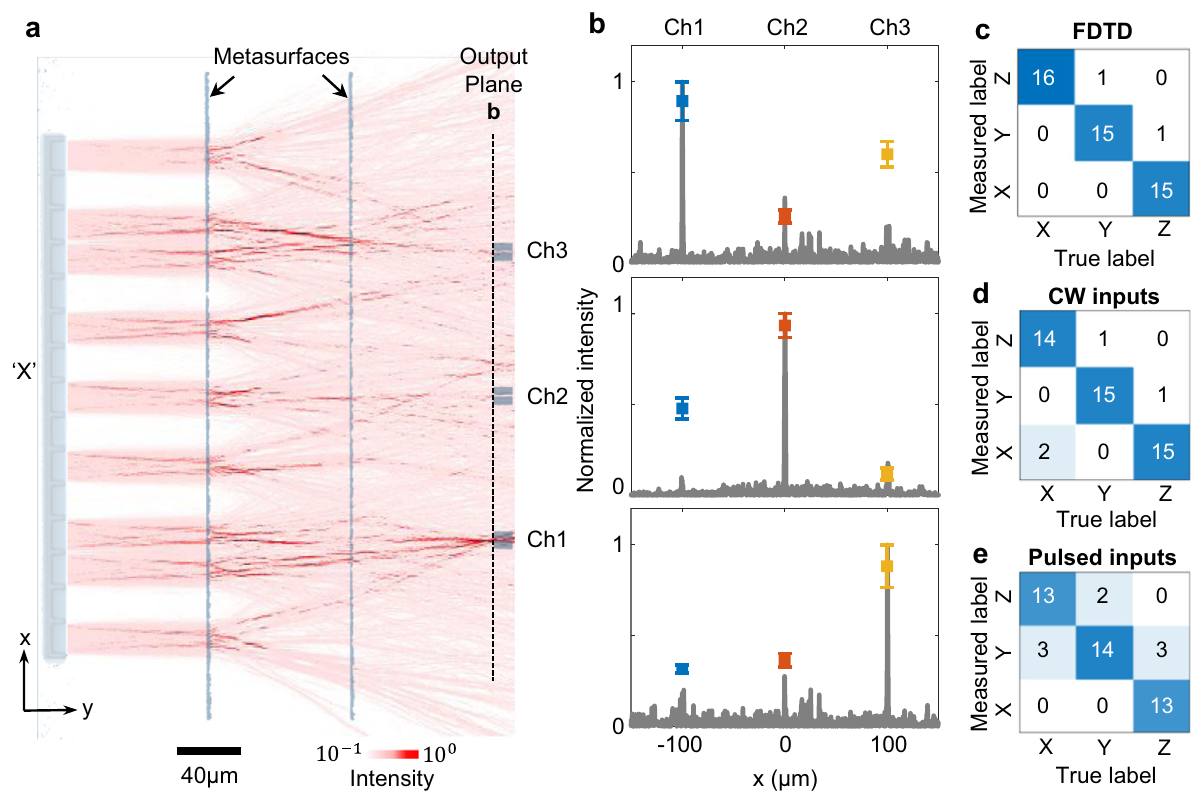
Fig. 3 Broadband pattern classi fi er. a The in-plane electric fi eld intensity distribution with the input patterns of ‘ X ’ (log scale), superimposed onto an optical microscope image of the correspondent metasystem device. b Comparison of measured optical intensities on the three waveguides placed on the output plane (dots with error bars) and the numerically simulated optical distribution on the output plane (gray curve). The error bars represent the standard deviation (s.d.) for 16 measurements. c Confusion matrix for numerical simulation and d measured results under CW excitation, with a center wavelength of 1550 nm and bandwidth of 2 pm. e Measured confusion matrix for a 90-femtosecond light source (centered at 1551.6 nm with a spectral bandwidth of 30 nm).